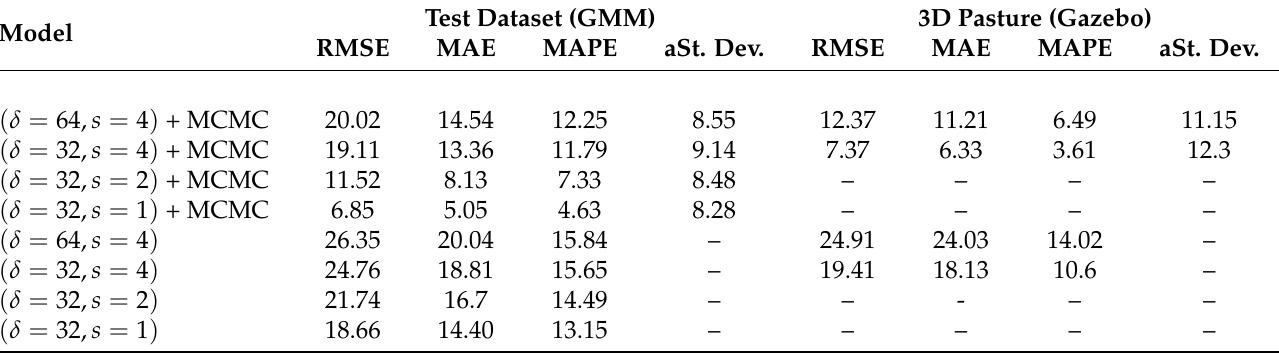
Table 1. Accuracy scores are averaged for each testing dataset over the time period ( L in = L out = 15 ) . The following models were tested ( δ = 64, s = 4 ) , and ( δ = 32, s = { 1,2, 4 } ) with and without approximate Bayesian inference (MCMC) with 500 samples and p l = 0.4. Accuracy is then calculated both for the test set from 2008 to 2009, and the 30 days sequence of point cloud measurements from 3D pasture simulated in Gazebo. RMSE, MAE and aSt. Dev. values are reported in ( mm ) and MAPE in ( % )